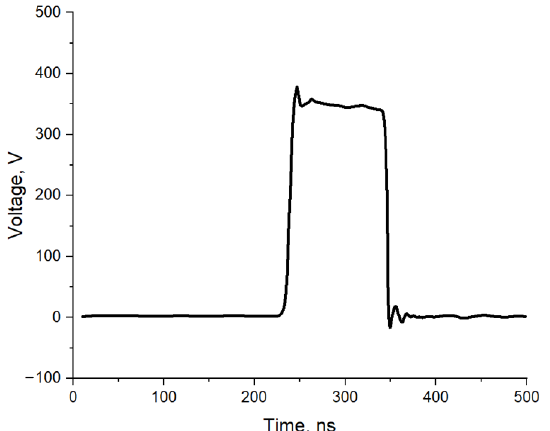
Figure 11. Measured shape of a single 107 ns 410 V/8.2 A pulse from GaN-based FSWP-51-06. Input DC voltage is 500 V.